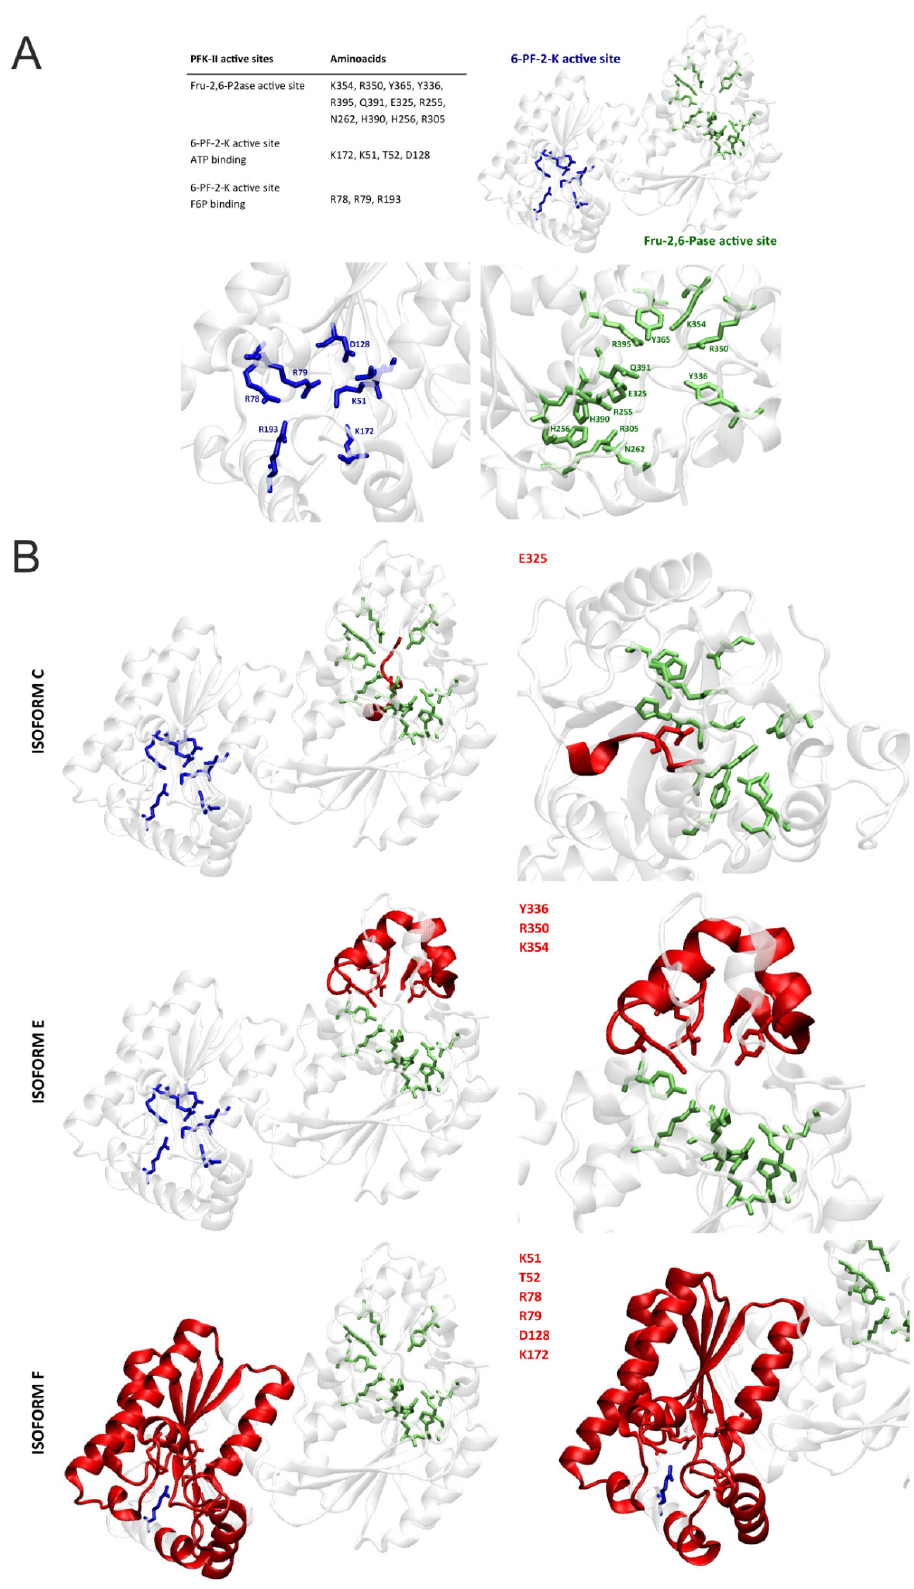
Figure 5. Visualization of PFKFB4 protein and its catalytic domains. ( A ) Left upper panel: Key amino acids of 6-PF-2-K and Fru-2,6-P2ase active sites. Right upper panel: Structure of Rattus Norvegicus PFKFB4 protein. The structure was obtained from the Protein Data Bank database with the following code: